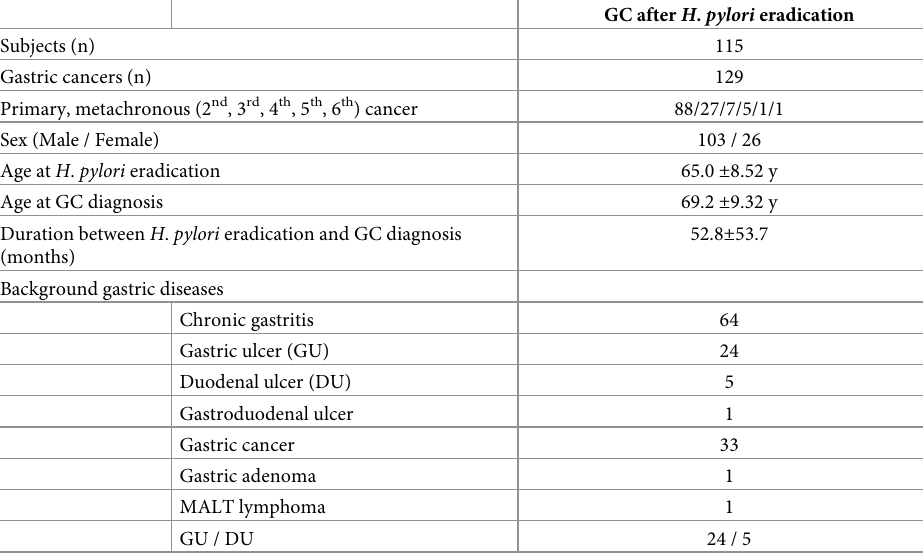
Table 1. Background of patients with gastric cancer following H . pylori